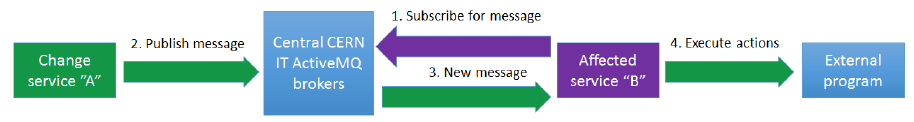
Figure 1. CERNMegabus